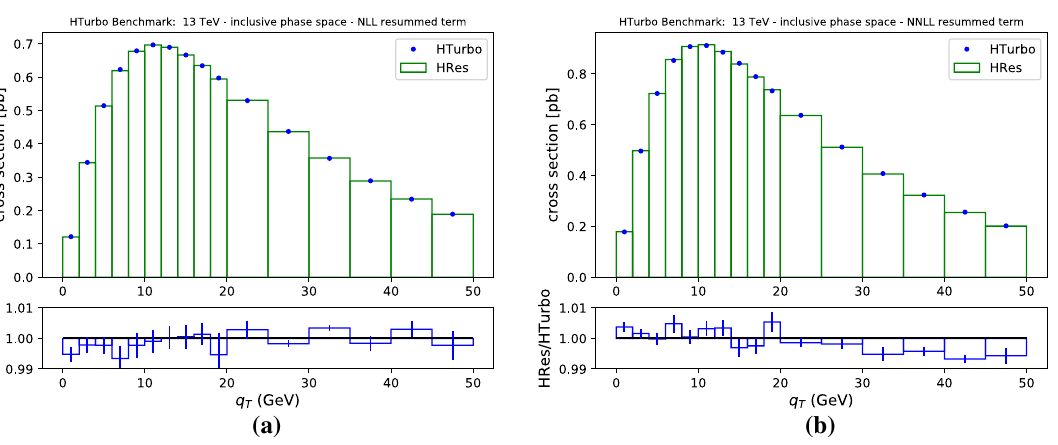
Fig. 1 Comparison of full-photon phase space differential cross sec- tions computed with HRes and HTurbo at component of the transverse momentum distribution at NLL ( a ) and